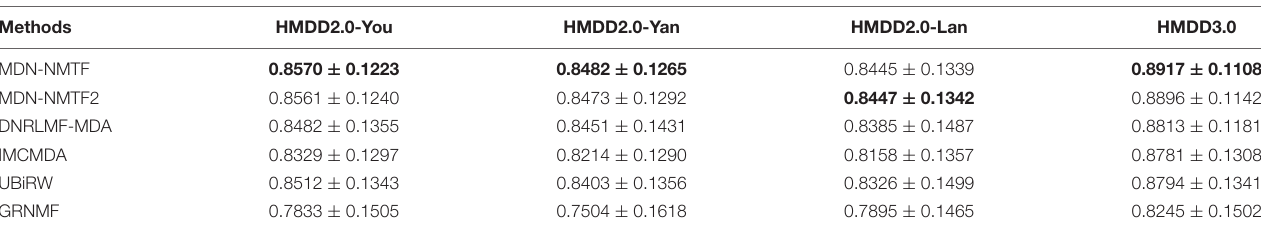
The table lists the AUC values of different methods on four different datasets. The AUC values of MDN-NMTF and MDN-NMTF2 are still the highest two. The results prove that our method considering the intrinsic module structure of miRNA and disease networks can improve the performance on miRNA-disease association predictions. The bold AUC values represent the highest AUC value of all method in the four different datasets.